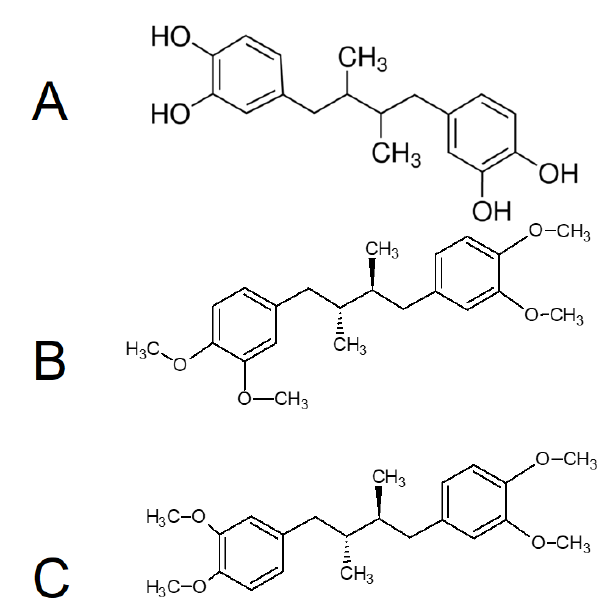
FIGURE 1 - Chemical structure of: A) Nordihydroguaiaretic acid (NDGA); B) Terameprocol; C) Nordihydroguaiaretic tetra-O-methyl acid (M4N).